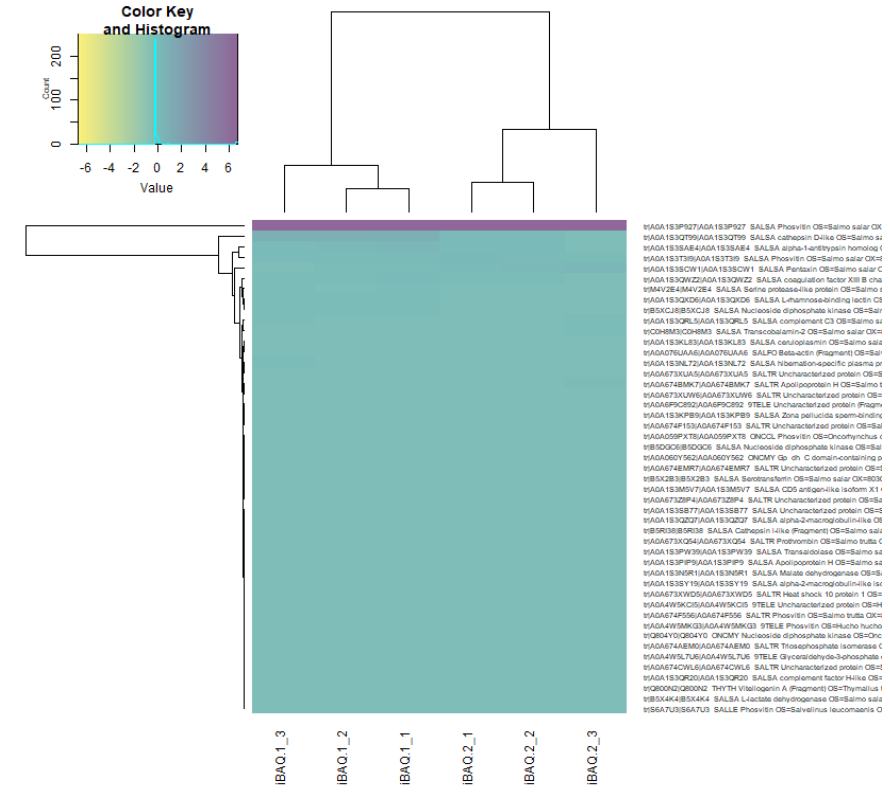
Figure 8. Heatmap LFQ Z-scores of normalized data in proteome of Atlantic salmon eggs ( Salmo salar L.) for control and experimental groups. Note: iBAQ1_X is a control group, iBAQ2_X is an experimental group, where “X” is a serial number. Quantities are presented in gradient format (legend top left). The upper dendrogram is the hierarchical clustering for the experimental group, the left dendrogram is for the identified proteins.